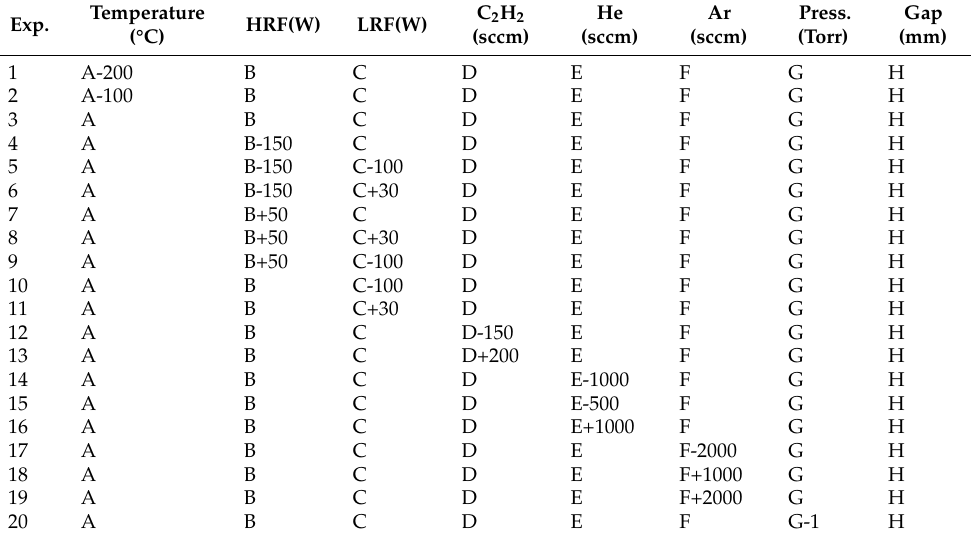
Table 1. DOE experimental parameters of the C 2 H 2 -based ACHM process studied in this work.